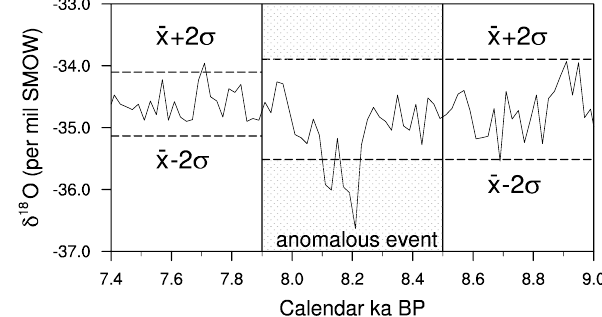
Fig. 2. Diagram of method used to detect climate anomalies at 8.2ka, as described in Figure 2. Diagram of method used to detect climate anomalies at 8.2 ka, as described in text. 3